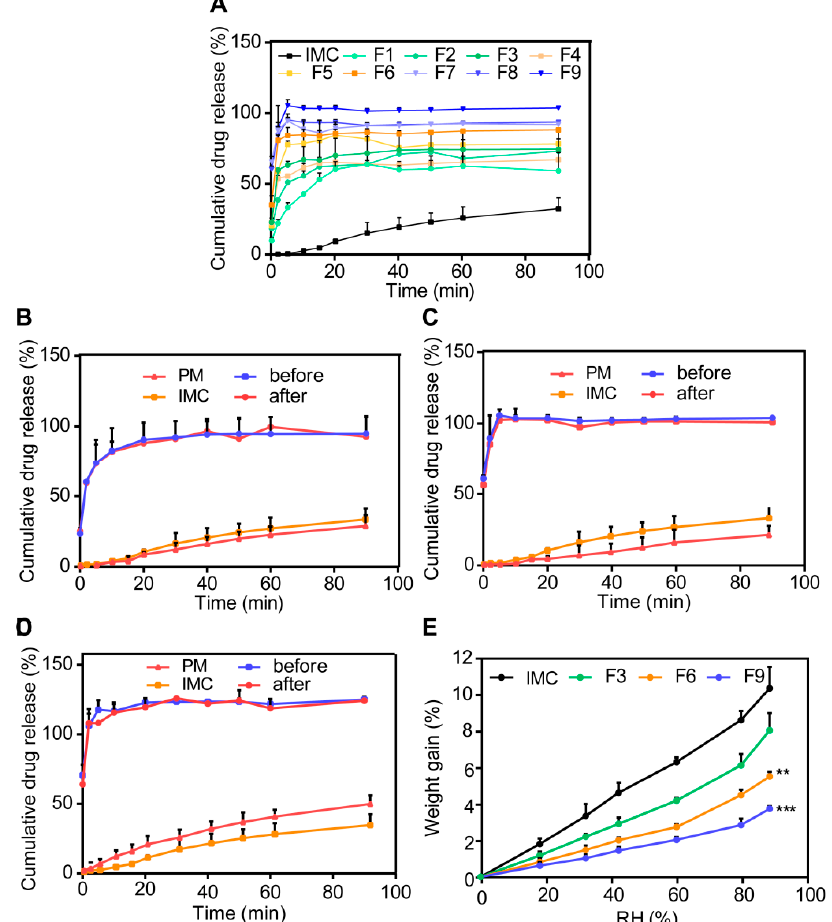
Figure 6. In vitro dissolution rate and moisture condition of IMC–SDs with di ff erent carriers that were stored for two months (mean ± SD, n = 3). ( A ) All SDs; ( B ) IMC–MSNs (F3); ( C ) IMC–MSNs@Kollicoat IR (F6); and ( D ) IMC–MSNs@HPMC (F9); ( E ) Moisture sorption properties of di ff erent IMC–SD systems: